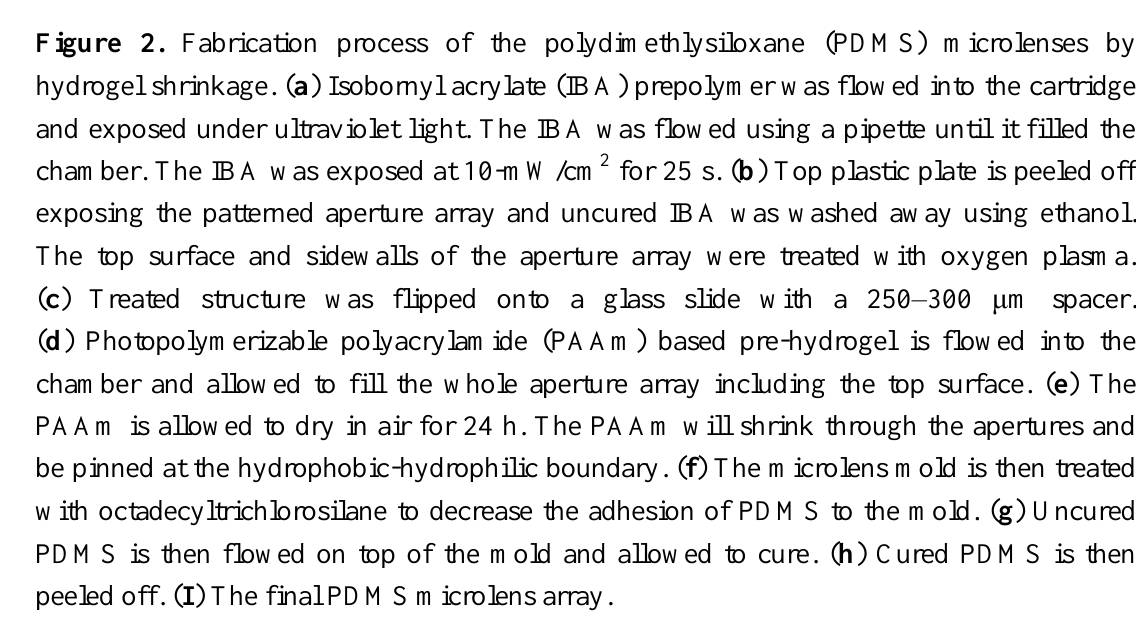
Figure 2. Fabrication process of the polydimethlysiloxane (PDMS) microlenses by hydrogel shrinkage. ( a ) Isobornyl acrylate (IBA) prepolymer was flowed into the